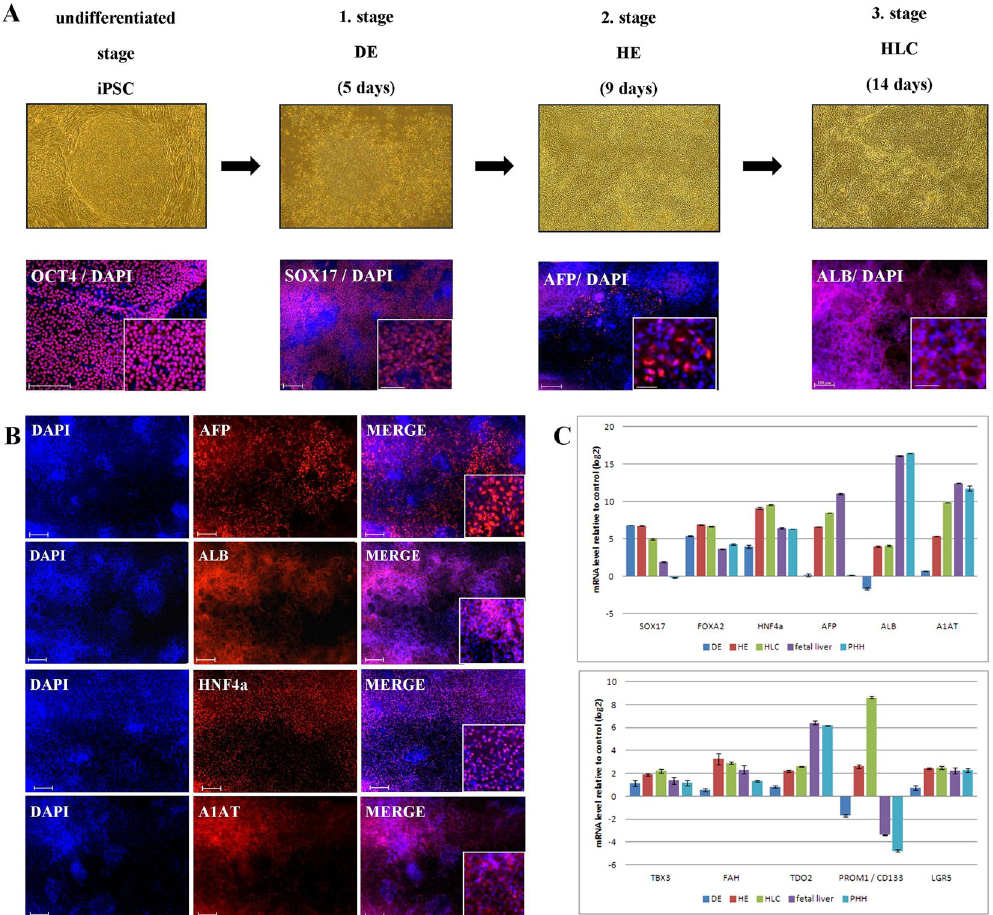
Figure 1. Derivation of hepatocyte-like cells (HLC) from E-iPSCs. ( A ) First row phase contrast images of the differentiation stages, from undifferentiated stage the episomal induced pluripotent stem cells (E-iPSCs) to definitive endoderm (DE), then hepatic endoderm (HE) and finally hepatocyte-like cells (HLCs). Second row immunofluorescence-based staining of stage specific proteins overlapped with DAPI (staining of nucleus). Scale bar: 100 μ m Alexa Flour 594 (red). ( B ) Immunofluorescence-based staining of HLC specific proteins AFP, ALB, HNF4 α and A1AT. Scale bar: 100 μ m Alexa Flour 594 (red). ( C ) Expression patterns of liver specific marker genes during HLC differentiation compared to fetal liver and primary human hepatocytes (PHH) are shown by quantitative real-time PCR (qPCR). Three biological replicates in technical triplicates of each sample were analyzed. The data were normalized to E-iPSCs. The standard deviation is depicted by the error